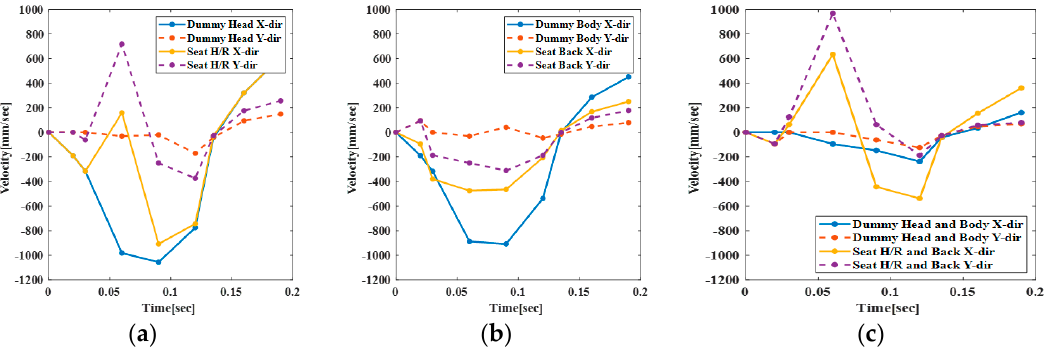
Figure 10. Velocities of proactive headrest seat and dummy in the x - and y -directions: ( a ) velocity of head and headrest; ( b ) velocity of dummy and seat; ( c ) relative velocity of dummy and seat.